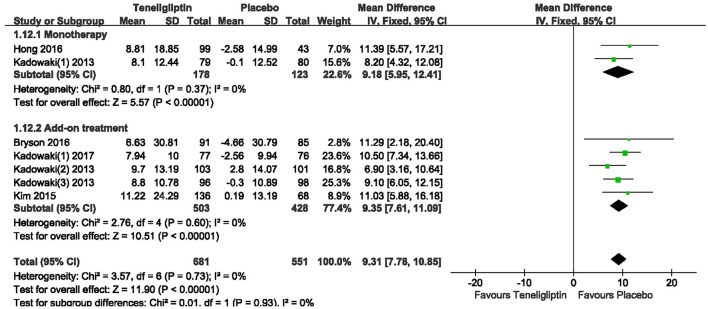
Effects of teneligliptin and placebo on HOMA-β change from the baseline by meta-analysis.